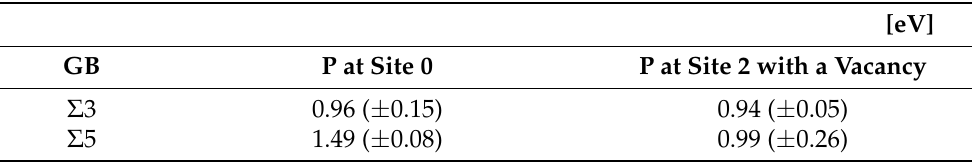
Figure 8. ( a ) The mean square displacement msd and ¯ D as a function of the strip length t i in the case of Σ 3 GB with a P atom at Site 0 at 800 K: The vertical dashed lines shows the range where ¯ D is obtained by averaging D i . Arrhenius plot ( b ) for Σ 3 GB and ( c ) for Σ 5 GB: The cases of a P atom at Site 0 and of a P atom at Site 2 with a vacancy at its nearest neighbor site are shown. V means vacancy. The error bar is the variance in averaging D i . Table 3. The evaluated barrier energy for P diffusion: The values in the parentheses are the fitting error in the Arrhenius